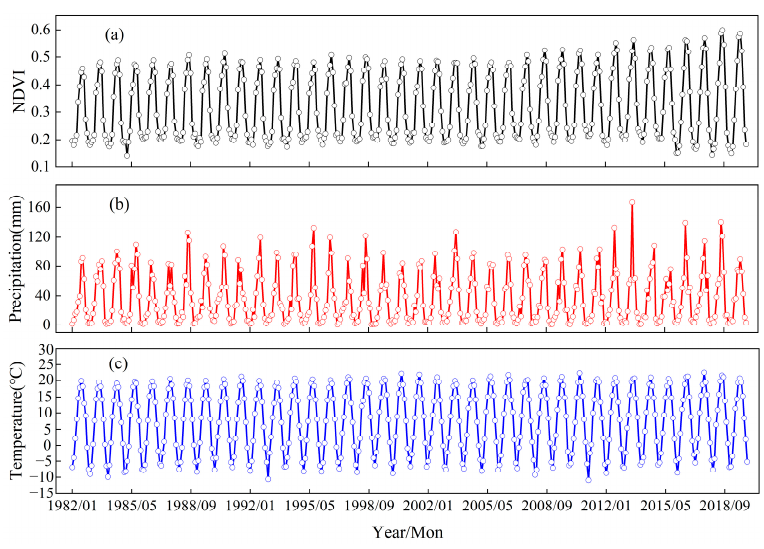
Figure 10. Temporal trend patterns of climate and the normal difference vegetation index (NDVI) in the Yellow River Basin (YRB). ( a ) NDVI, ( b ) precipitation (mm), and ( c ) temperature ( ℃ ).